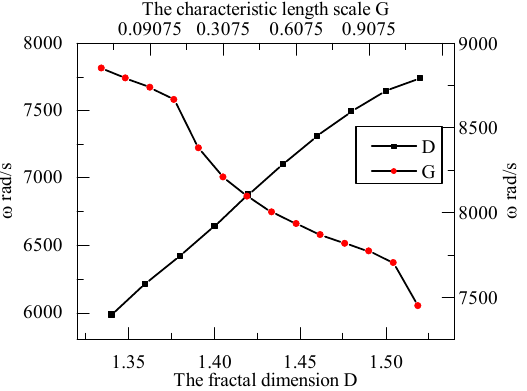
Figure 10. Effects of the fractal dimension D and characteristic length scale G on the natural frequency of the rod fastening rotor system.